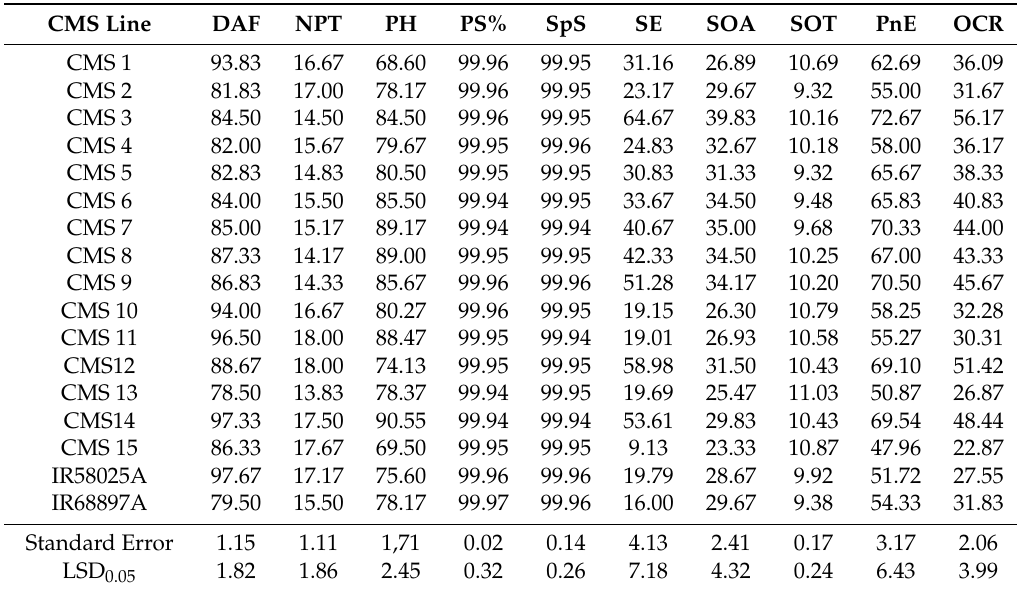
Table 5. Agronomic and floral traits of 17 newly-bred CMS lines and two checks. CMS